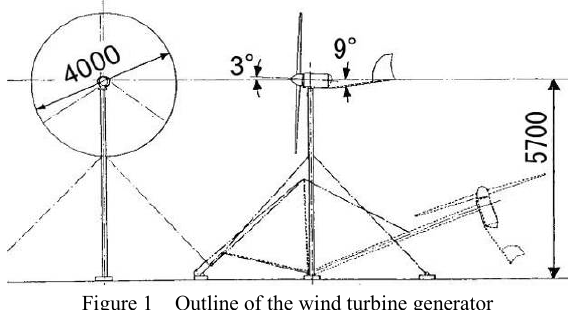
Figure 1 Outline of the wind turbine generator